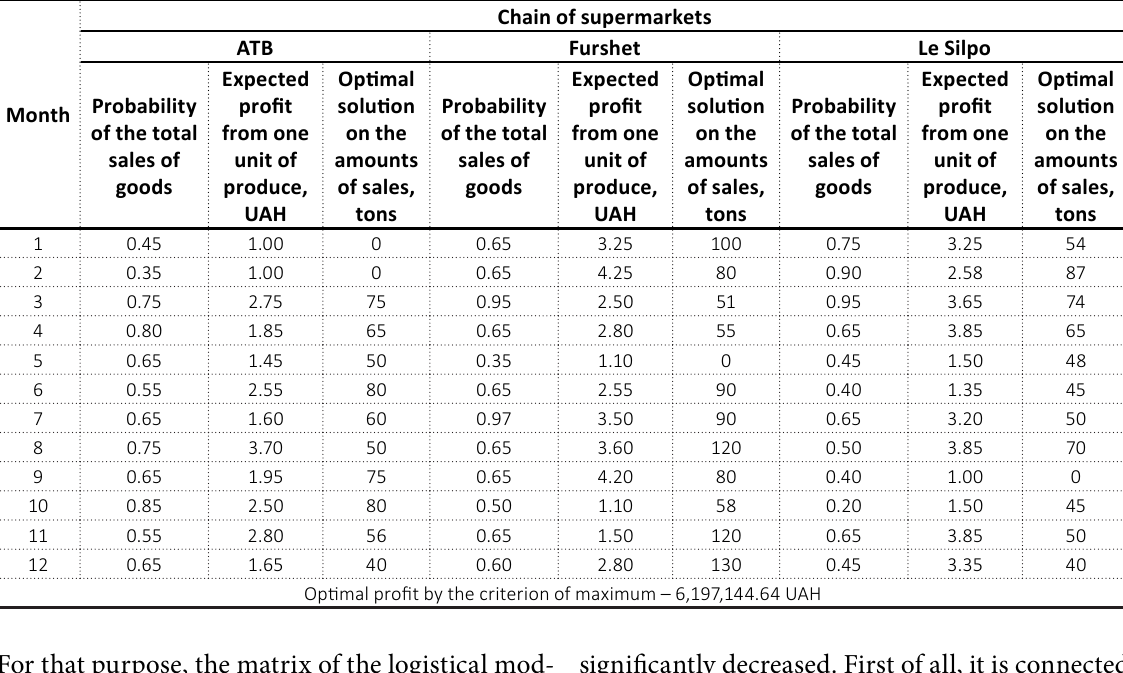
Source: Developed by the